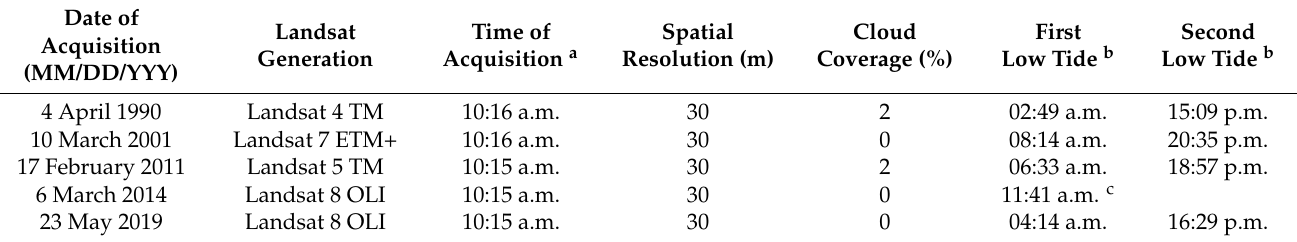
Table 1. Landsat data acquisitions used for seagrass mapping and change